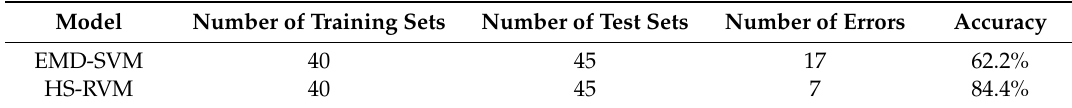
Table 7. Test set diagnostic results of the EMD-SVM